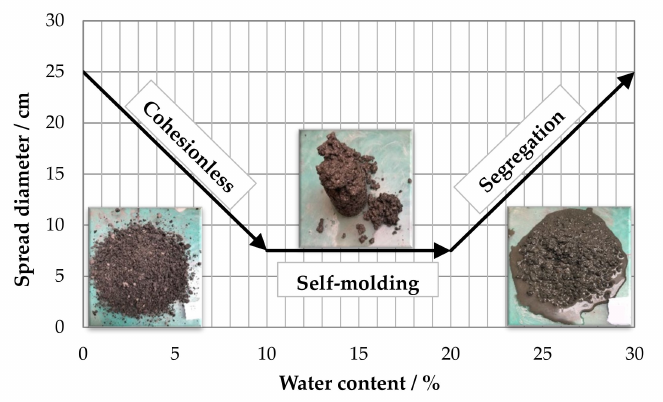
Figure 3. Flowability trend of